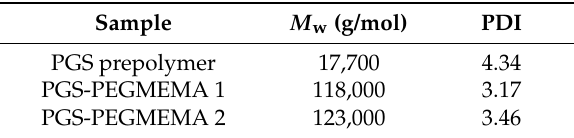
Table 1. The molecular weights of PGS-PEGMEMA 1 and